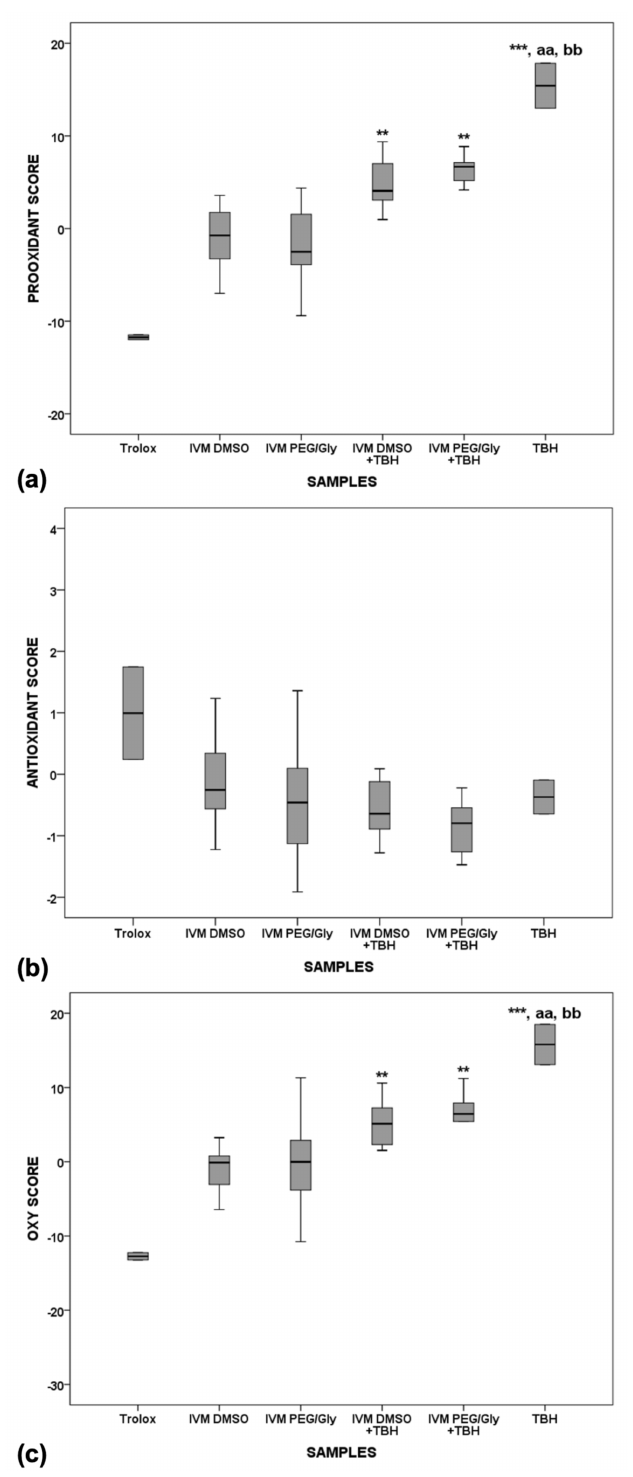
Figure 6. Pro-oxidant ( a ), antioxidant ( b ) and oxy-scores ( c ) after 2 h of incubation. ** p < 0.01 vs. Trolox; *** p < 0.001 vs. Trolox; aa p < 0.01 vs. IVM DMSO; bb p < 0.01 vs. IVM PEG/Gly. After the 24-h incubation (Figure 7), Trolox alone showed the lowest oxidative effect in serum compared with IVM solutions alone ( p < 0.001), IVM solutions with TBH ( p < 0.001), and TBH alone in serum ( p < 0.001). TBH alone in serum still shows the highest pro-oxidant potential and a statistically significant difference is observed compared to Trolox alone, as well as to both IVM solutions alone in serum. While there is a significant